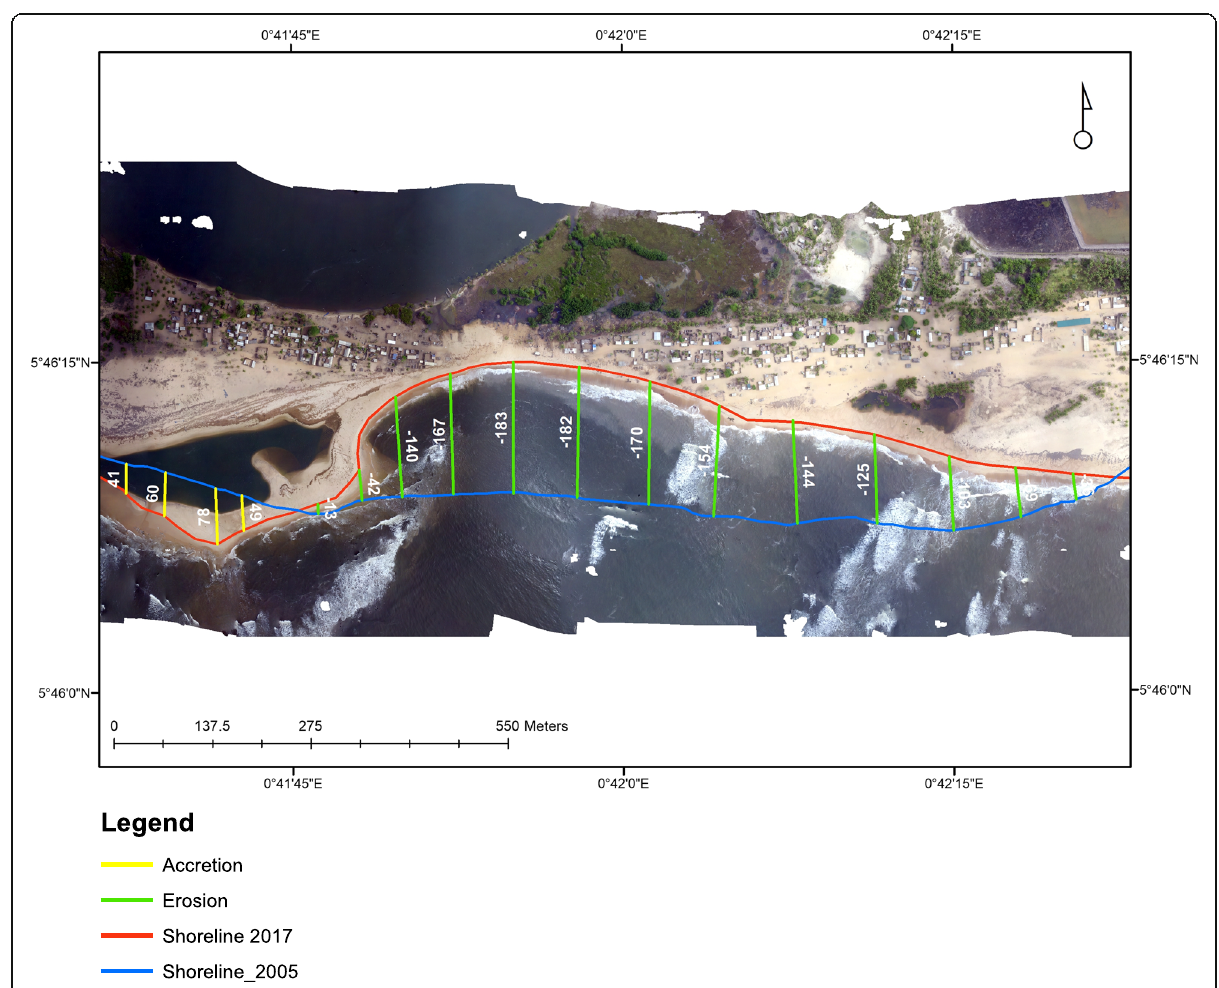
Fig. 4 Overlay of 2005 shoreline position on 2017 drone image showing land lost inland along